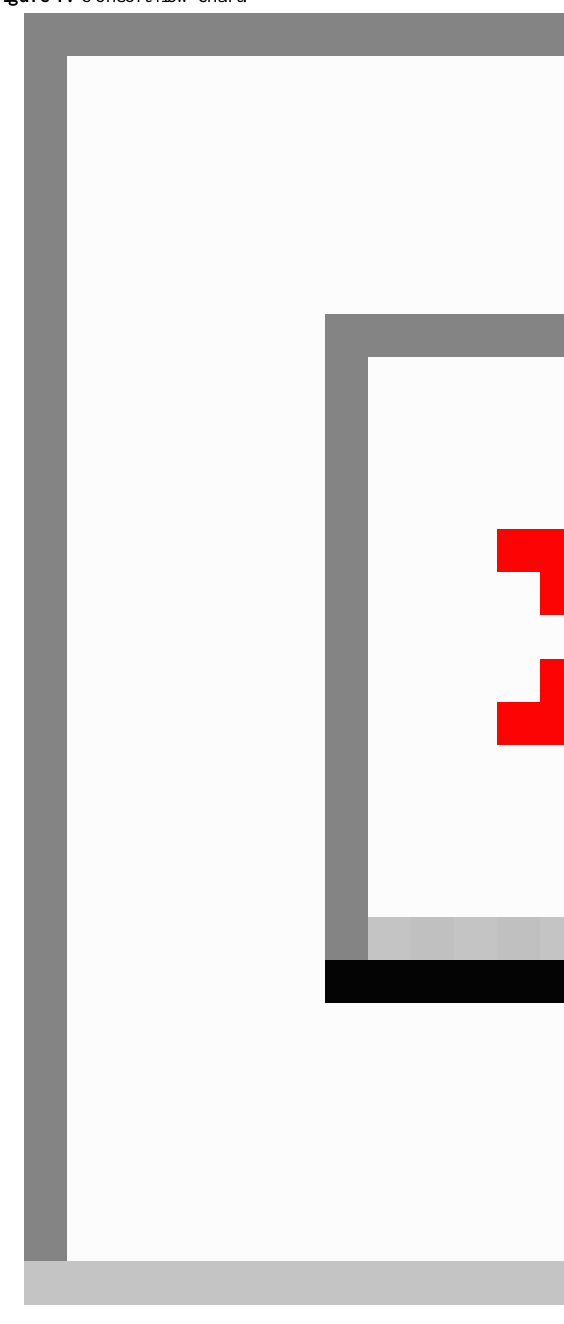
Figure 1. Consort flow